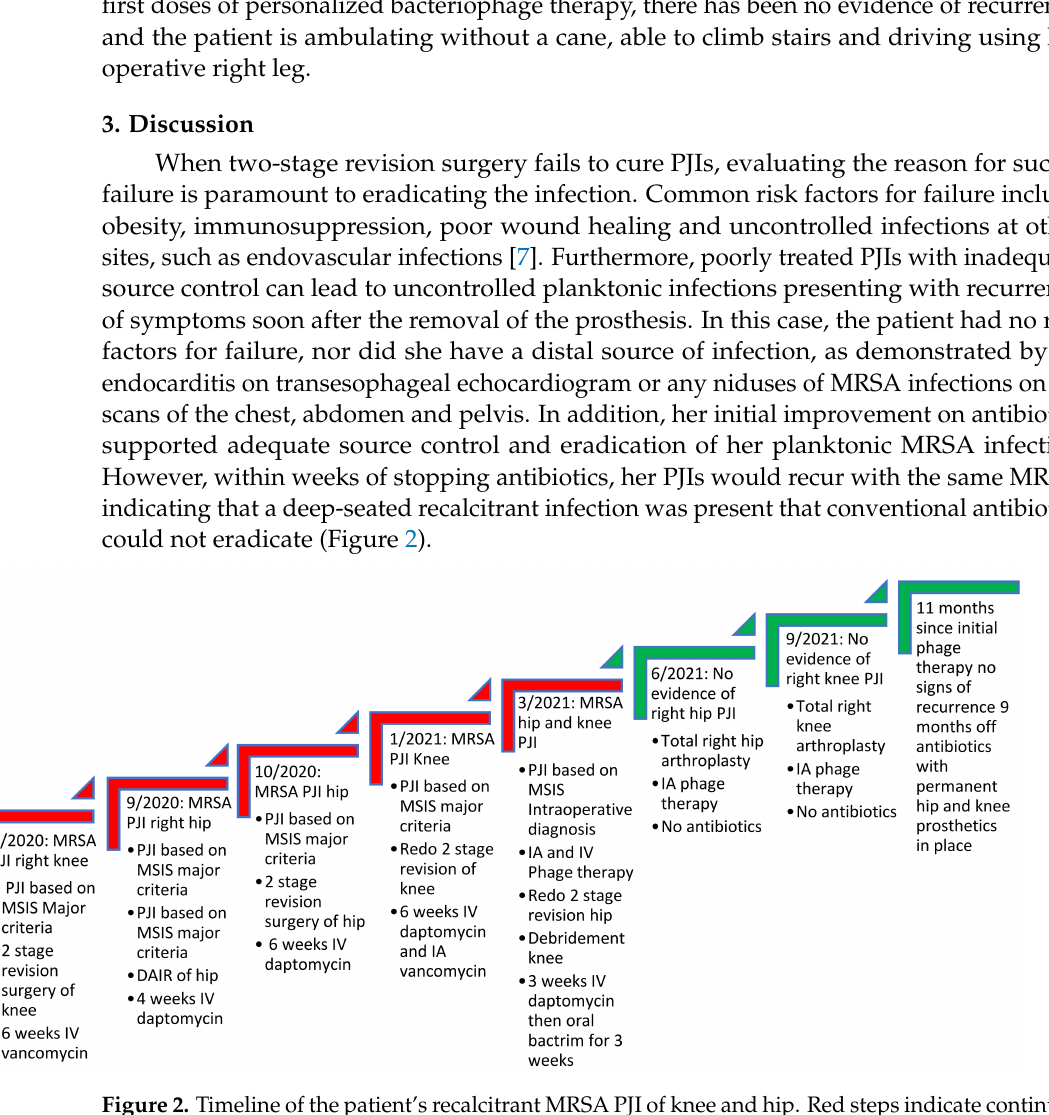
Figure 2. Timeline of the patient’s recalcitrant MRSA PJI of knee and hip. Red steps indicate continued infection, while green steps indicate resolution of infection as seen with no clinical symptoms and sterile deep tissue bacteriological cultures. The figure shows it was not until bacteriophage therapy was used that cure of infection occurred. IA refers to intraarticular administration. DAIR refers to debridement and implant retention surgery. MSIS refers to musculoskeletal infection society. The MSIS criteria for PJI diagnosis are well documented elsewhere